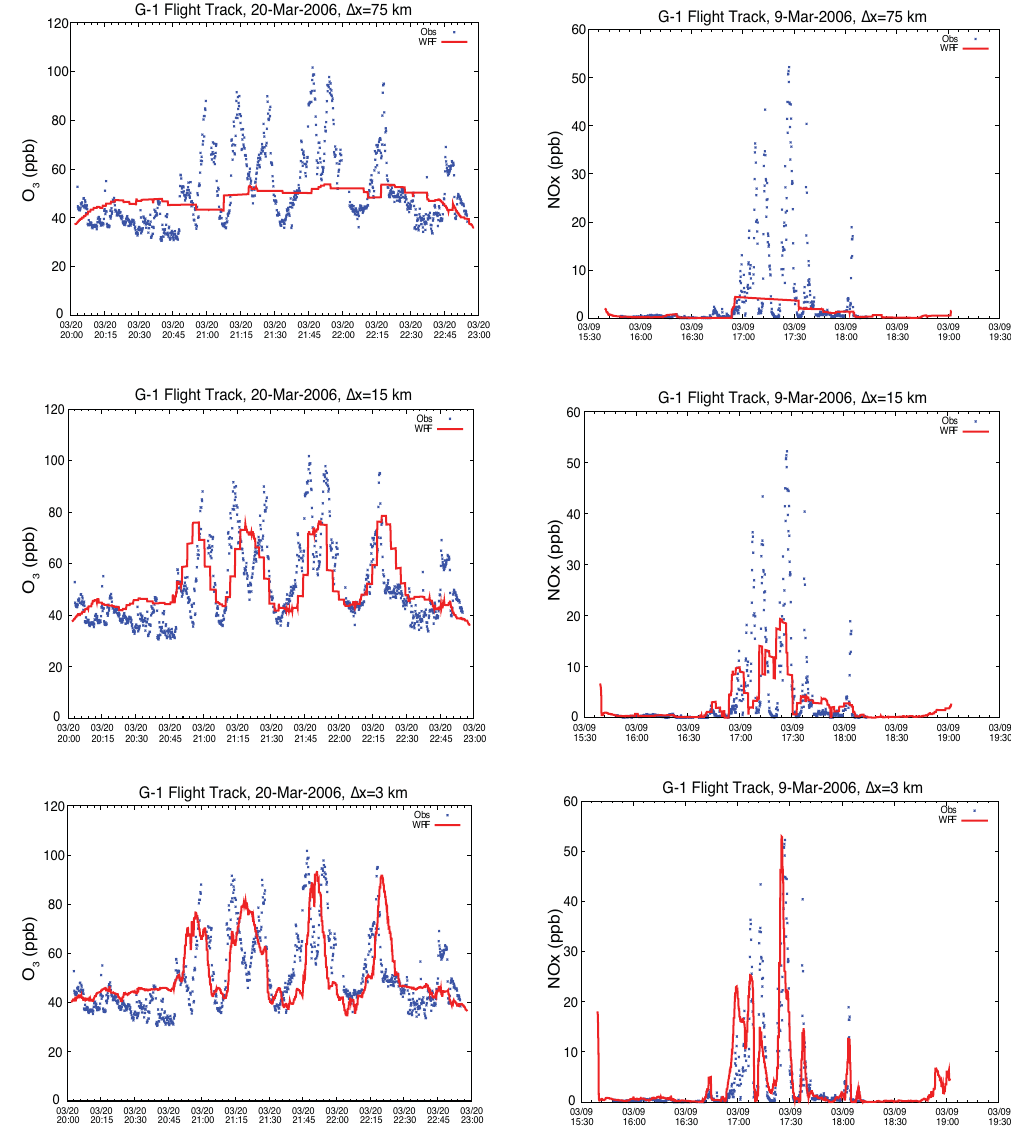
Fig. 6. Observed (blue) and simulated (red) O 3 mixing ratio along the G-1 flight path on 20 March (left column, unit: ppb) and NO x mixing ratio along the G-1 path on 9 March (right column, unit: ppb) for 75-km (top), 15-km (middle), and 3-km (bottom) simulations,